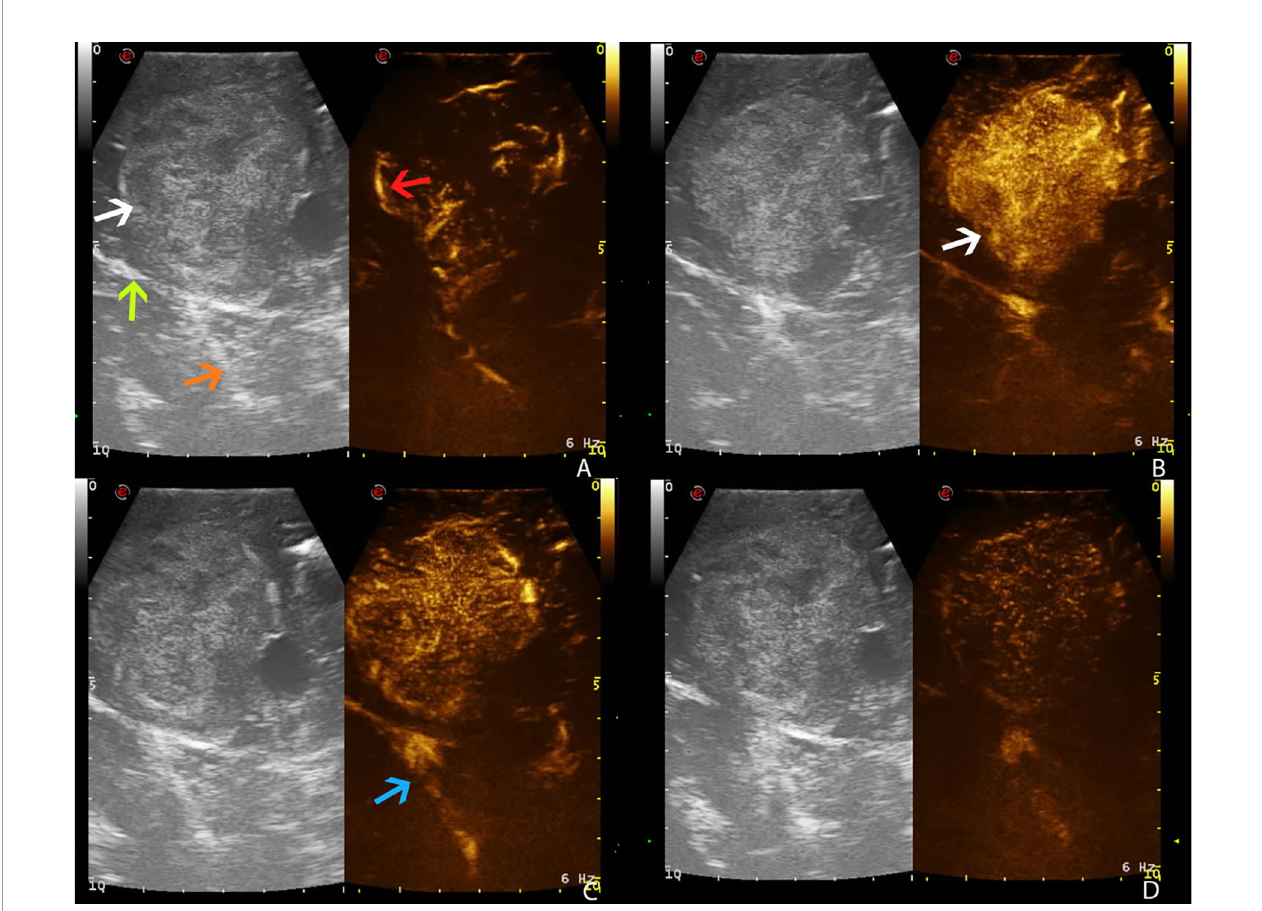
FIGURE 5 | Intraoperative time frame of different CEUS phases in a right temporo-parietal fi brous meningioma (case no. 5, Intra-op), showing the exact correspondence between preoperative and intraoperative US images, thus con fi rming the reliability of preoperative IOUS (see for preoperative images). (A) Arterial phase. (B) CE peak. (C) Parenchymal phase. (D) Venous phase. White arrow: fi brous meningioma. Green arrow: falx cerebri. Orange arrow: tentorium cerebelli. Red arrow: arterial supply. Blue arrow: deep venous